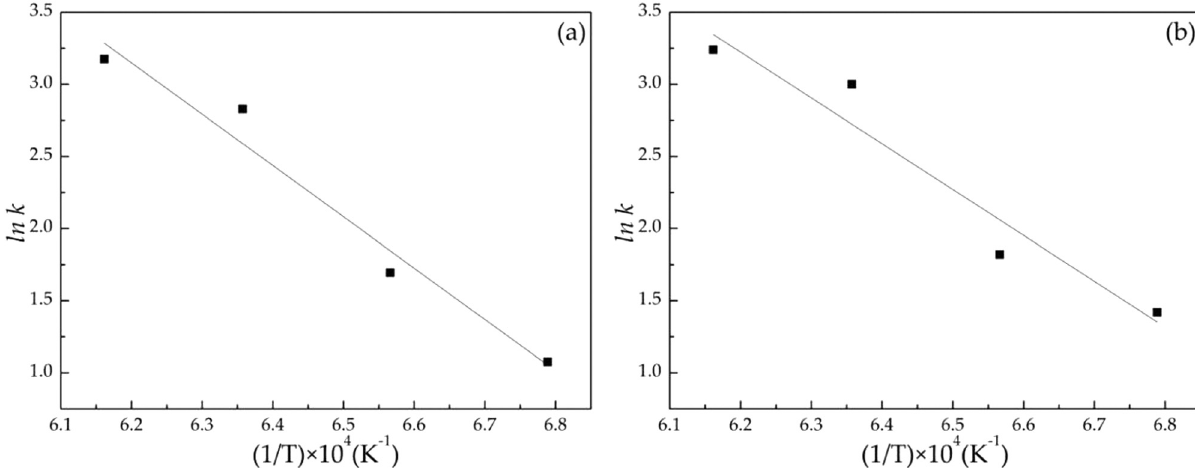
Figure 8: Fitting plots of ln k and 1/ T at di ff erent temperatures: ( a ) SiO 2 , ( b ) fl y ash.